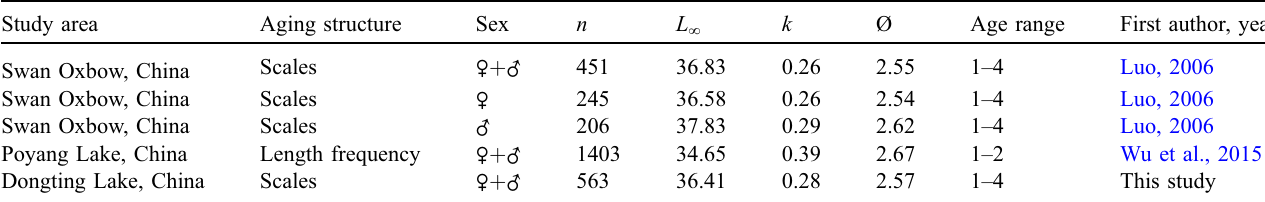
Table 3. Summary of parameters of von Bertalanffy growth equation for Coilia brachygnathus from different studies. Study